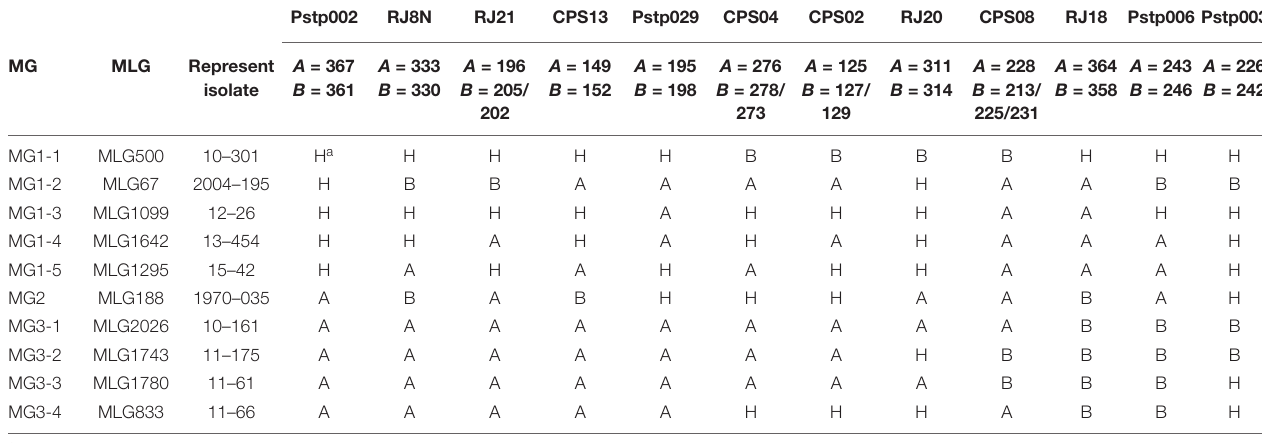
TABLE 6 | Allelic genotypes at each simple sequence repeat (SSR) locus of the represent isolate in each molecular group of Puccinia striiformis f. sp. tritici .